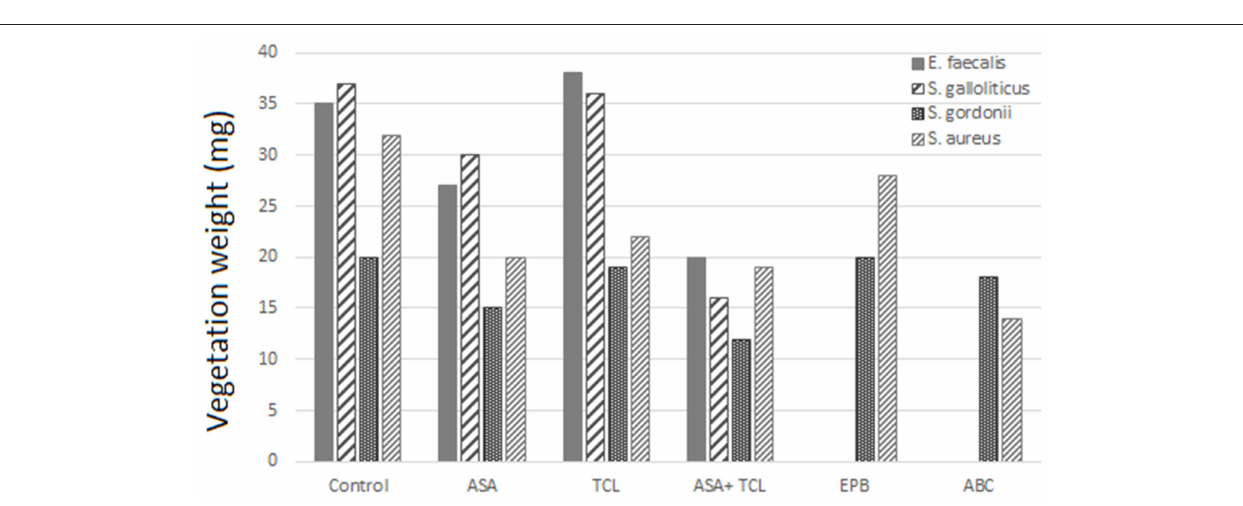
FIGURE 4 | Effect of antiplatelet agents on endocardial vegetation weight in the animal model. Effect of aspirin (ASA), ticlopidine (TCL), alone or in combination, as well as eptifibatide (EPB) and abiciximab (ABC) on weight of vegetation induced by E. faecalis , S. gallolyticus , S. gordonii , and S. aureus . Eptifibatide and abciximab in the case of S. gordonii and S. aureus (84,